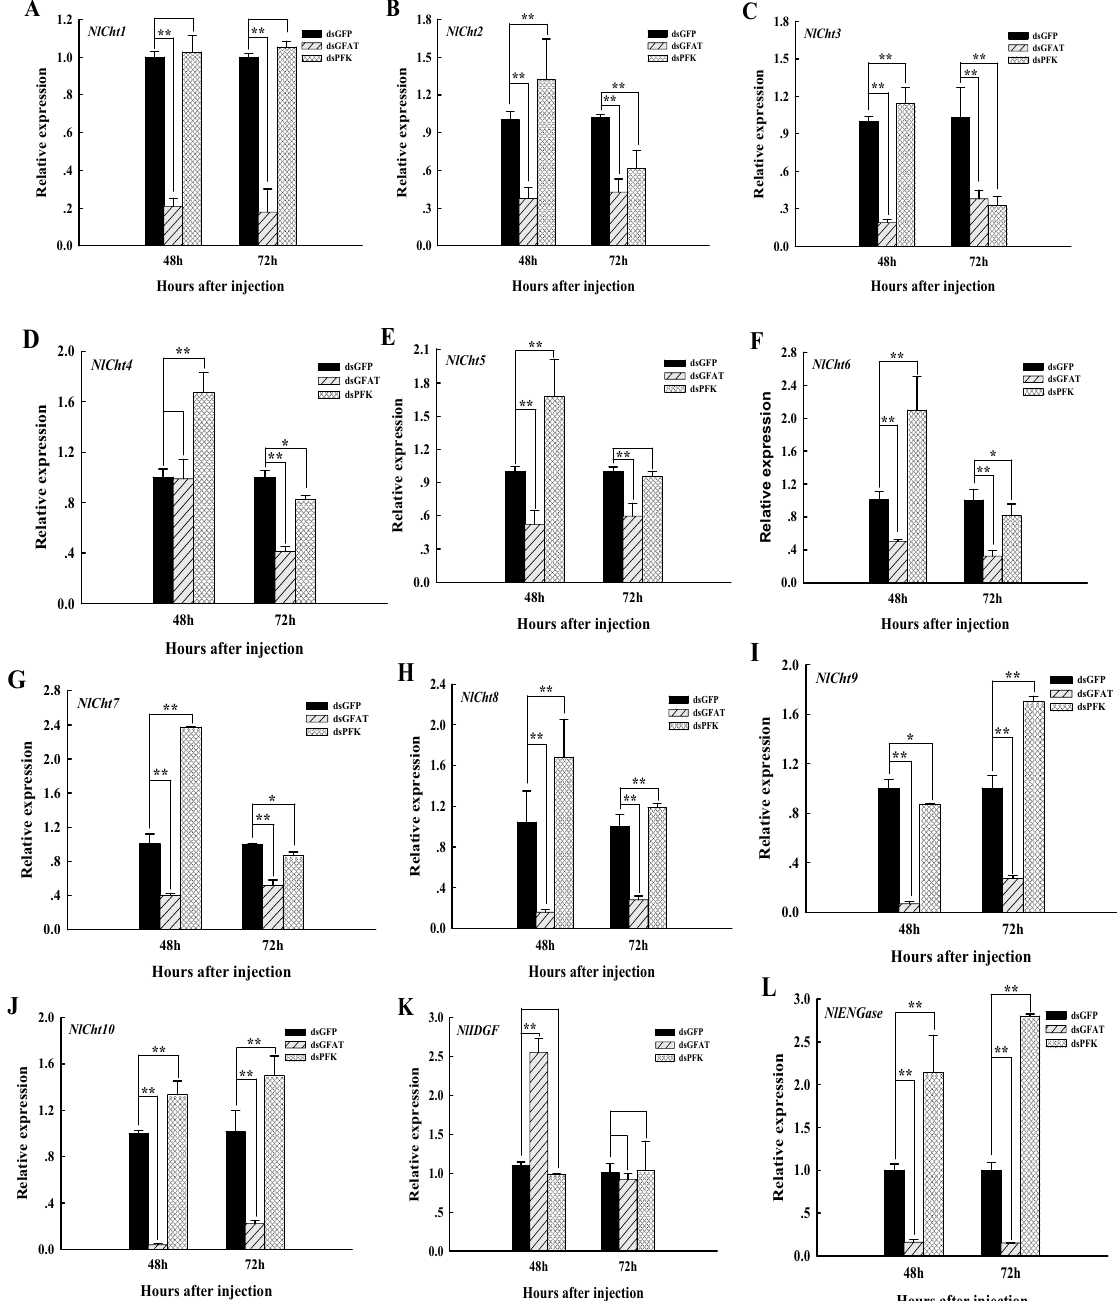
Figure 6. Relative expression levels of chitin degradation-related genes at 48 h and 72 h after dsRNA injection. GFAT, glutamine:fructose-6-phosphate aminotransferase; PFK, phosphofructokinase; Cht, chitinase; IDEF, imaginal disc growth factor; ENGase, endo-β-N-acetylglucosaminidase. Nilaparvata lugens larvae at the 1st day of the 5th instar stage were divided into three groups and injected with dsGFP, dsGFAT, and dsPFK, respectively. Insects were collected and used to determine the relative expression levels of Cht1 to Cht10 (A to J), IDGF (K), and ENGase (L) at 48 h and 72 h after dsRNA injection. Three replicates were performed per group. *, significant differences ( P < 0.05); **, extremely significant differences ( p <